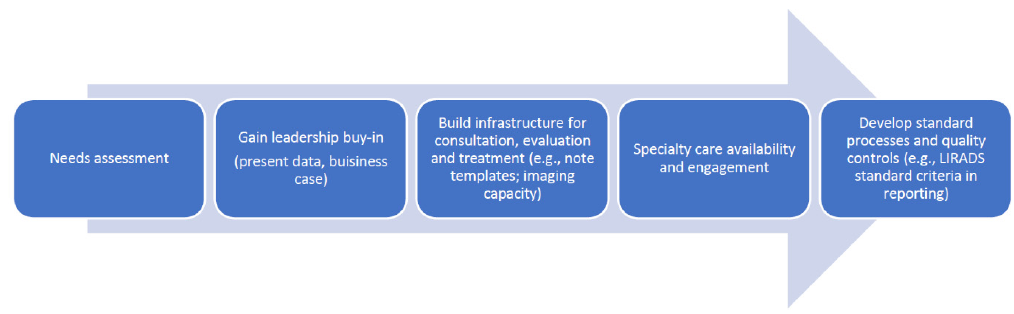
Figure 1. Steps to develop a multidisciplinary tumor board.